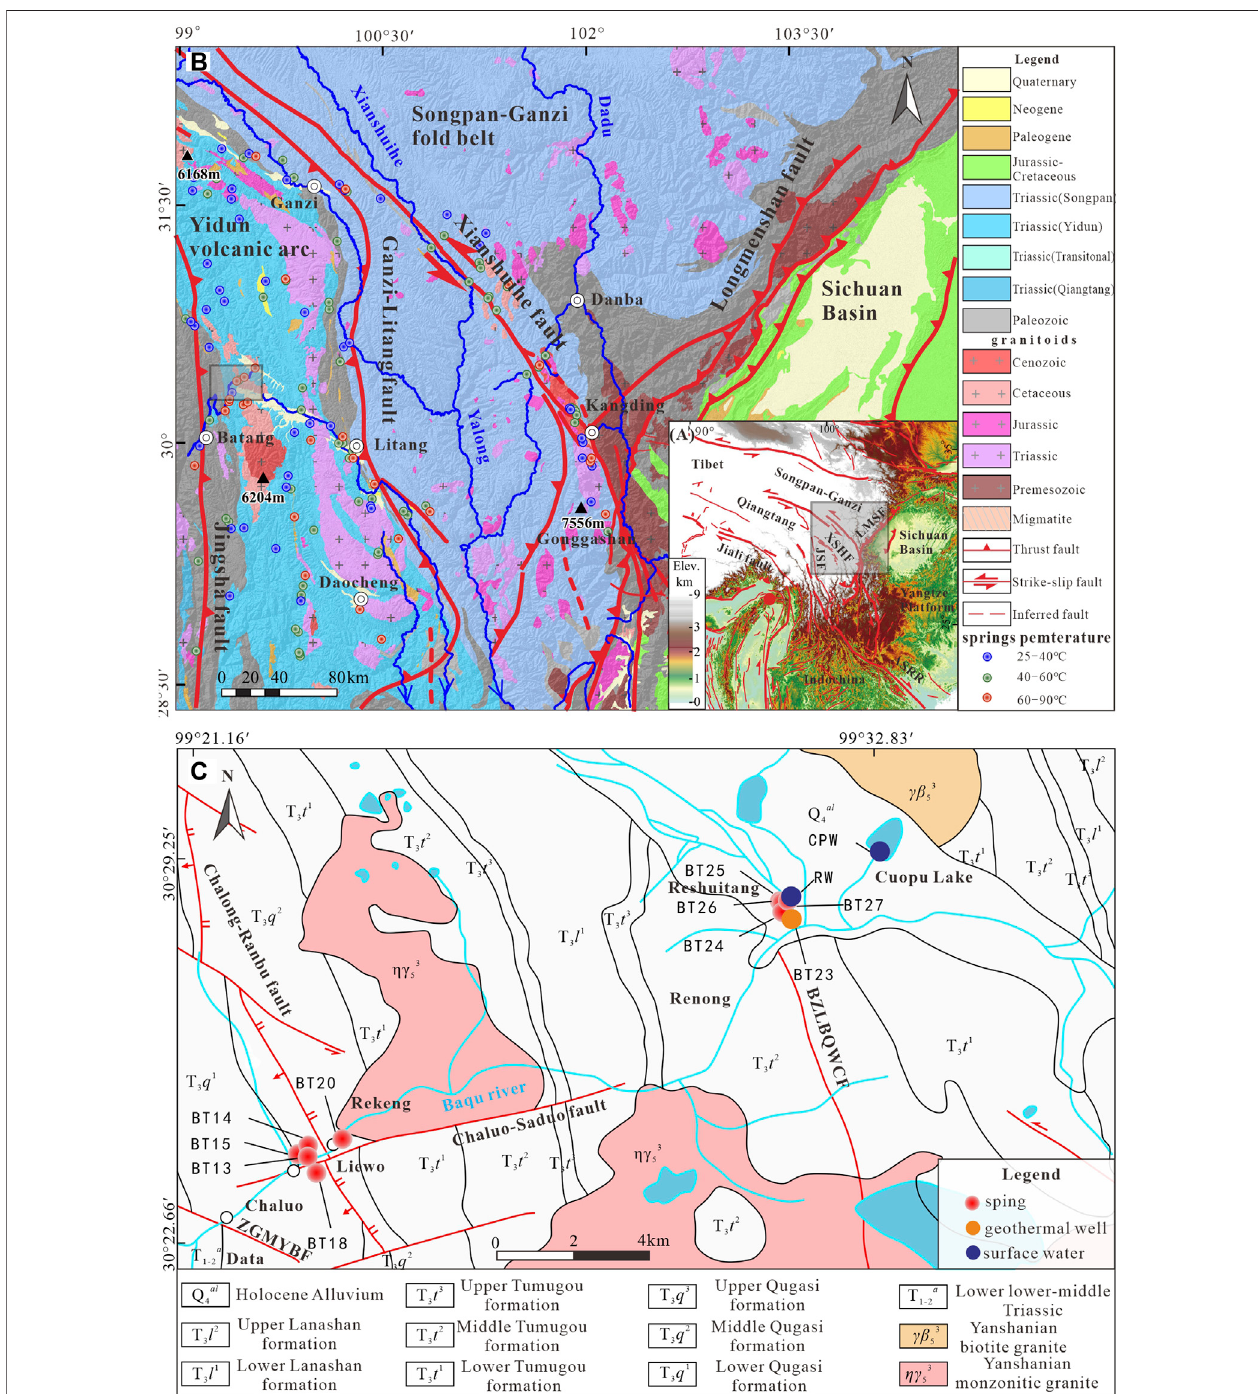
FIGURE1|(A) TopographicmapofsouthwestChina; (B) GeologicalmapofthesoutheasternmarginoftheTibetanPlateau(accordingtoZhangY.-Z.etal.,2017; Tang and Johnnesson, 2010). (C) Geological map of the Chaluo area, Batang County, western Sichuan Province.